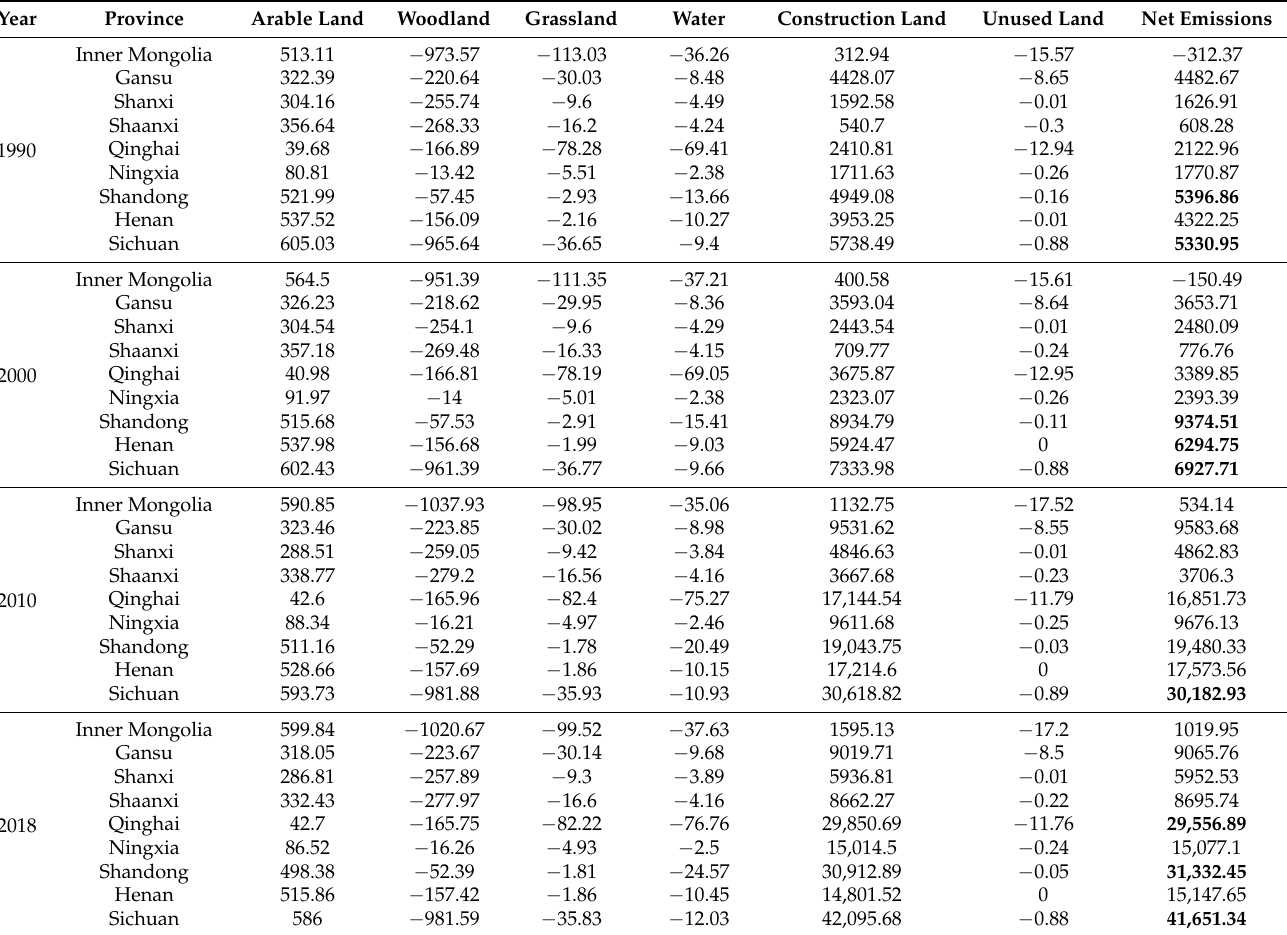
Table 4. Carbon emissions from land-use types in the study area by province (10 4